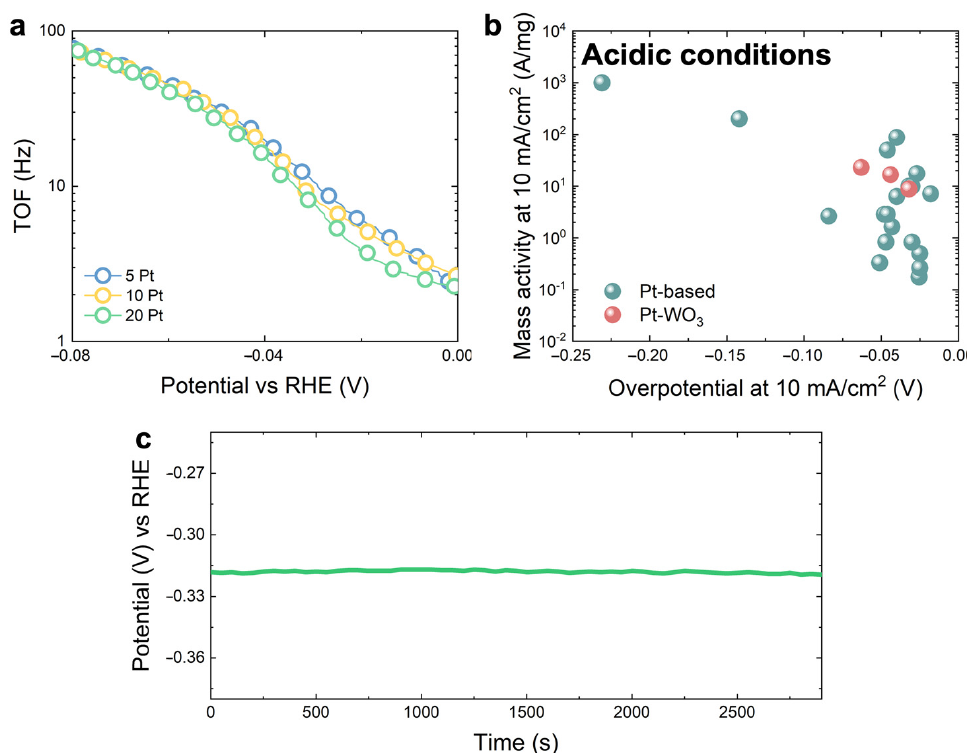
Figure 3. ( a ) TOF of the 5Pt_WO 3 , the 10Pt_WO 3 , and the 20Pt_WO 3 electrodes (red, blue, yellow, and green circles, respectively) as a function of the overpotential; ( b ) comparison between the mass activity of the Pt-based electrodes reported in the literature (blue balls) [6] and our Pt-decorated WO 3 electrodes (red balls); ( c ) chronopotentiometry analysis of the 20Pt_WO 3 electrode. Table 2 compare our results with that reported in the literature on Pt-decorated metal oxide frameworks, for HER in acidic conditions. Our electrodes show a Pt content (of the order of µ g/cm 2 ) 2–3 orders of magnitude lower than others, and, despite this, their electrochemical performances are much better in terms of overpotential, Tafel, TOF, and mass activity. The 20Pt_WO 3 electrode possesses the lowest η , thus revealing a very efficient HER process, confirmed also by the high TOF value at − 15 mV, which is due to the high activity of the electrochemical active